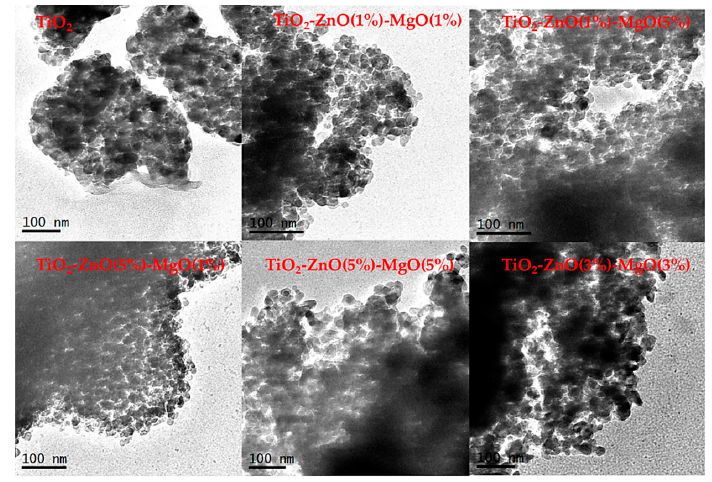
Figure 2. Transmission electron microscopy (TEM) images from pure TiO 2 and mixed oxide materials.